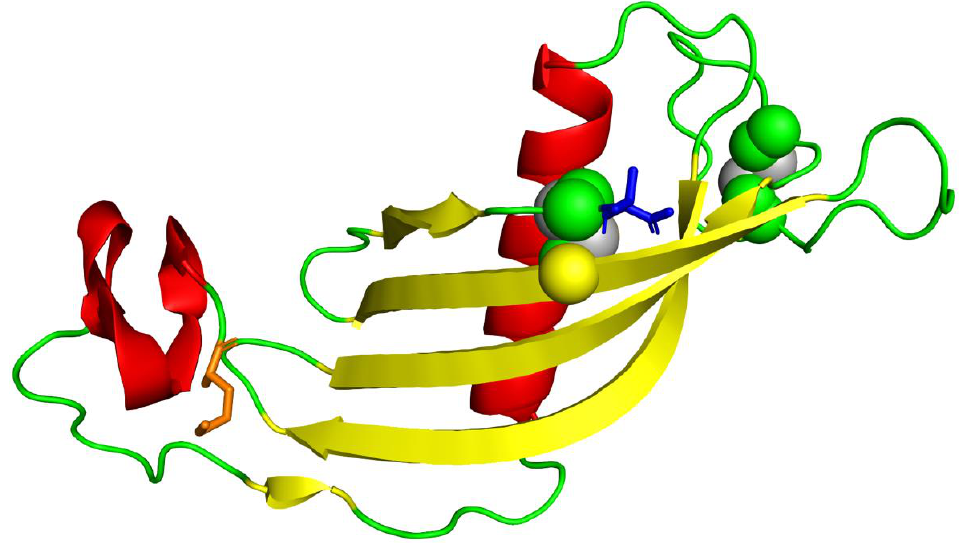
Figure 4. Refined tertiary structure model produced by ReFOLD server. The N-terminus (protein start) is colored in orange, the C-terminus (protein end) in blue, beta-sheets in yellow, alpha helices in red, and disulfide bonds in gray.